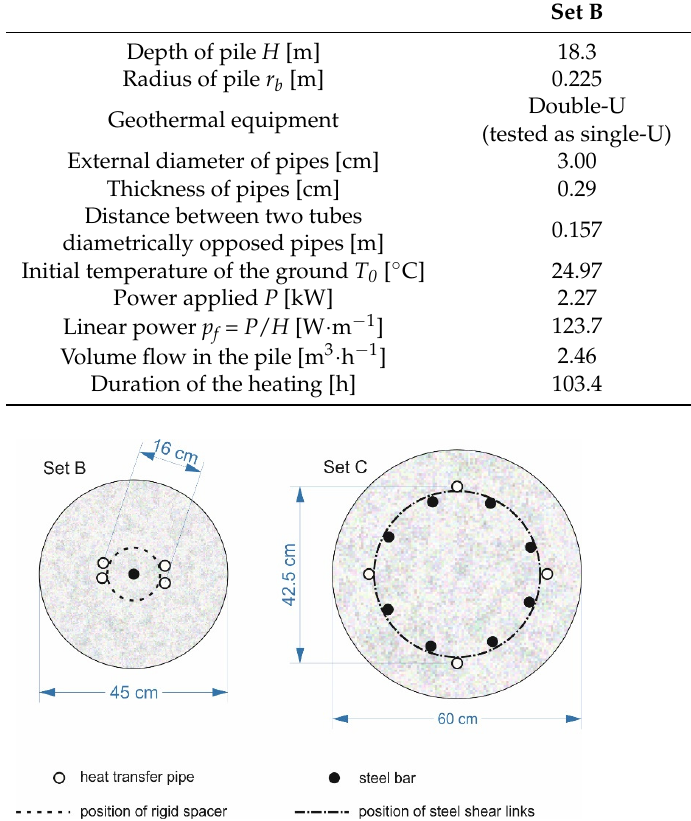
Table 1. Characteristics of the TRT.